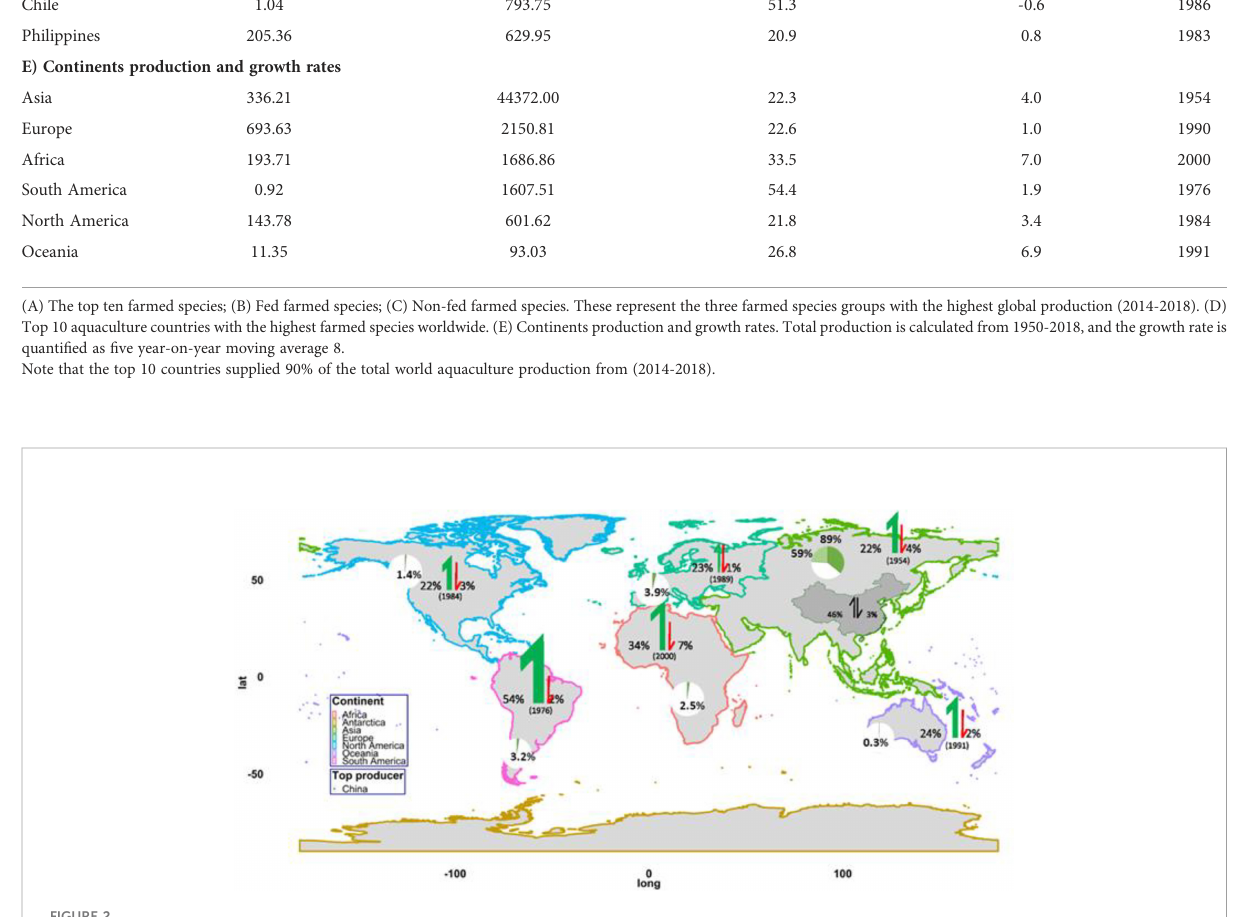
FIGURE 2 Global aquaculture production and growth rates. Pie charts show the global aquaculture production (%) by continents from 2014 to 2018. Asian pie chart also illustrates the percentage of contribution from the world ’ s largest ’ producer (China). Green and red arrows indicate the fi ve year- on-year moving average growth rate (%) before the peak growth rate and fi ve-year moving average between 2014 and 2018,